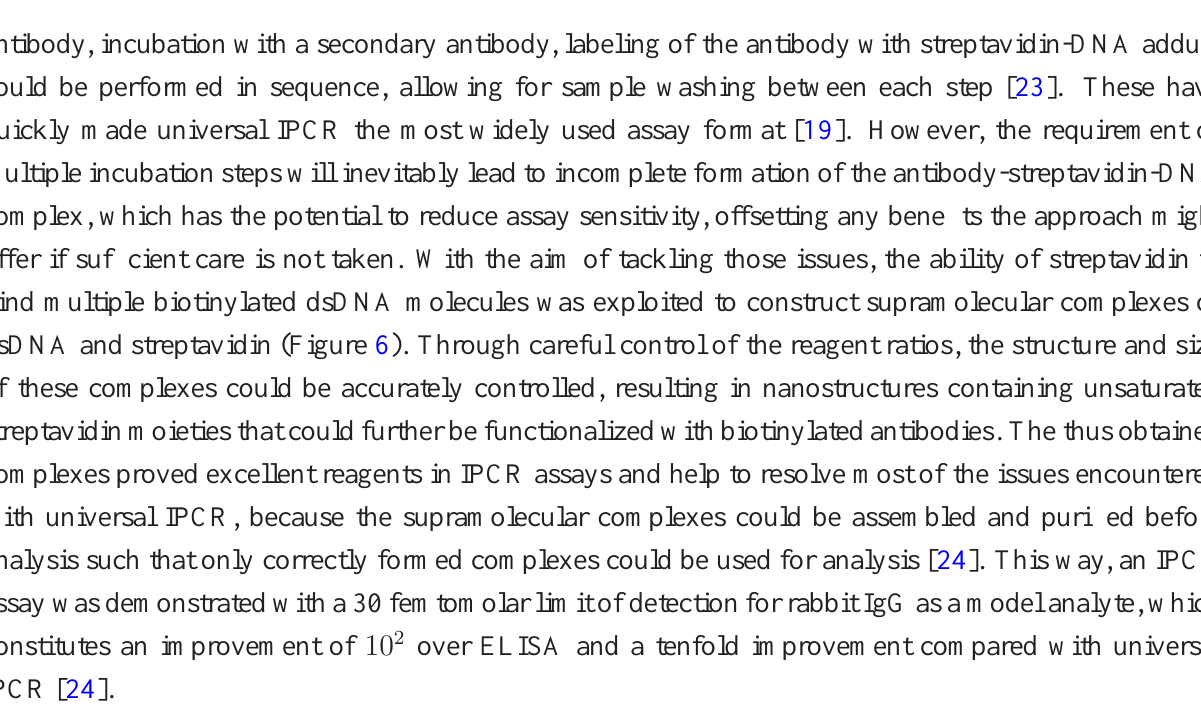
Figure 6. Schematic representation of self-assembled oligomeric DNA-protein complexes used in IPCR. Mono- and bis-biotinylated dsDNA was mixed with equimolar amounts of streptaidin to generate oligomeric DNA-streptavidin complexes. The